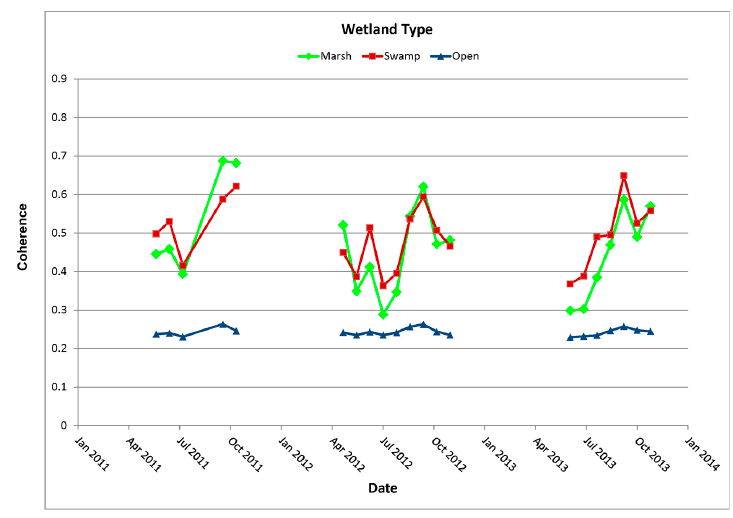
Figure 2. Coherence as a function of time for marsh, swamp and open wetland types.